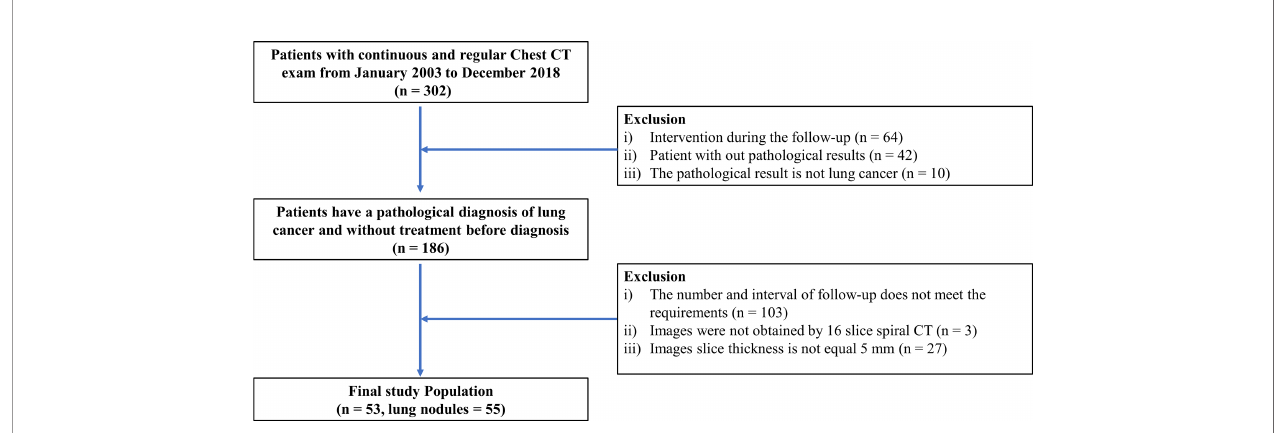
FIGURE 1 | Flowchart for study